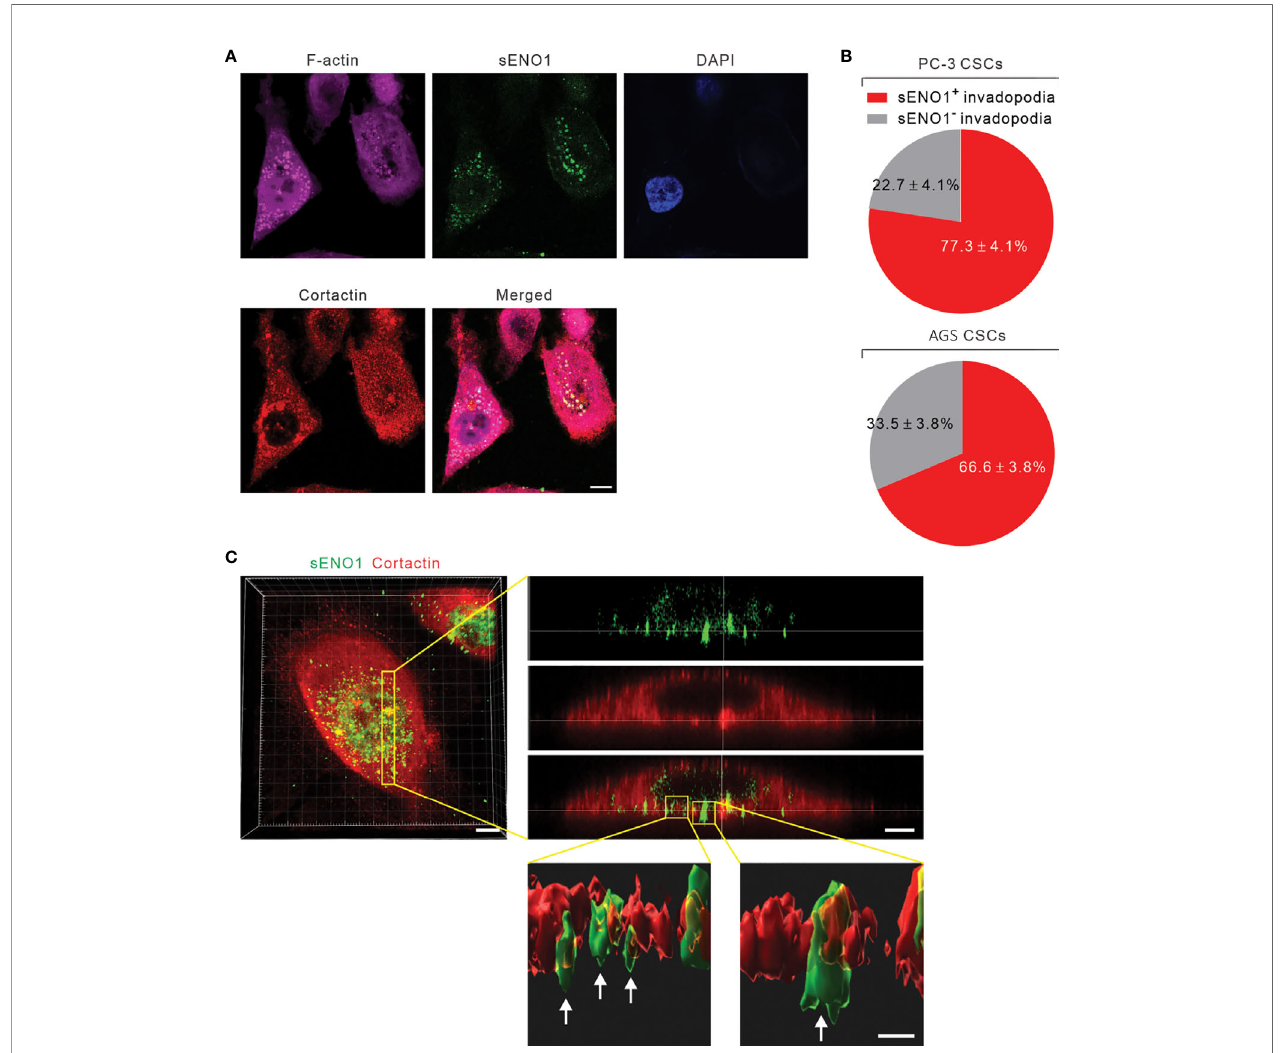
FIGURE 4 | ENO1 is expressed on the invadopodial surface of CSCs. (A) Confocal views of PAC CSCs (represented by CD44 + CD133 + PC-3 cells) showing the cross-section of invadopodia structures (represented by cortactin + F-acin + puncta) with the colocalized surface ENO1 (sENO1; green), cortactin (red), and F-actin (magenta) that penetrate into the underlying gelatin matrix. Nuclei were counterstained with 4 ’ ,6-diamidino-2-phenylindole (DAPI; blue). Scale, 10 µm. (B) Top, a pie chart showing the percentage of sENO1 + invadopodia per PC-3 CSC. Bottom, a pie chart showing the percentage of sENO1 + invadopodia per GAC AGS CSC (represented by CD90 + AGS cells). (C) Left, representative three-dimensional (3D) reconstructed confocal image of CD44 + CD133 + PC-3 CSCs showing the co- localization of sENO1 (green) and cortactin (red) at the ventral side of cell. Scale, 8 µm. Right upper, digital zoom-in image from serial Z sections (yellow rectangle) showing the spatial colocalization of sENO1 (green) and cortactin (red) at invadopodia. Scale, 5 µm. Right lower, the orthogonal view of the magni fi ed areas (yellow squares at top) shown the distribution and localization of sENO1 and cortactin at the base of invadopodia. 3D rendered images of the invadopodia (arrows) were processed by using Imaris software. Scale, 1